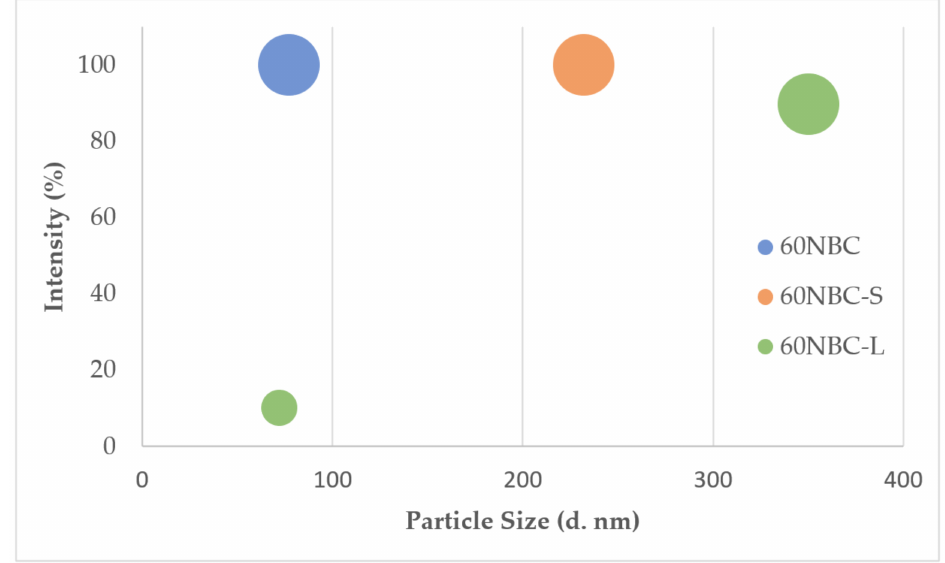
Figure 2. The effect of the grinding media on the particle size distribution of the